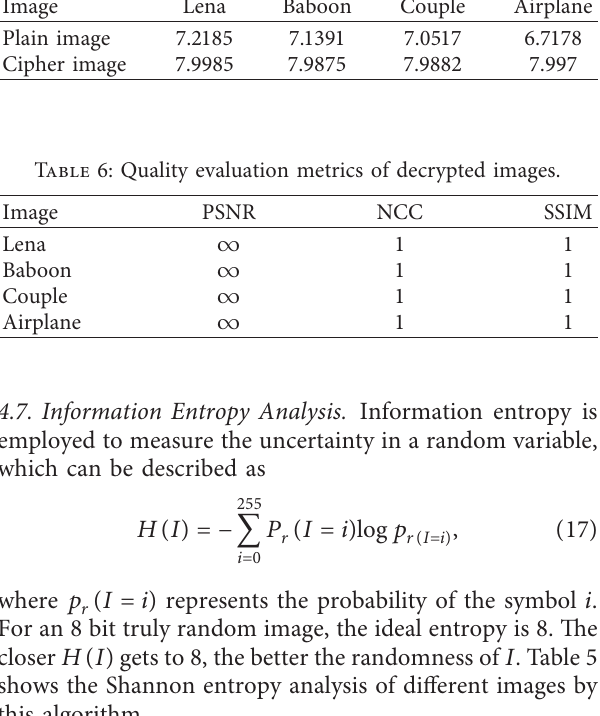
Table 5: The Shannon entropy analysis of different images. Image